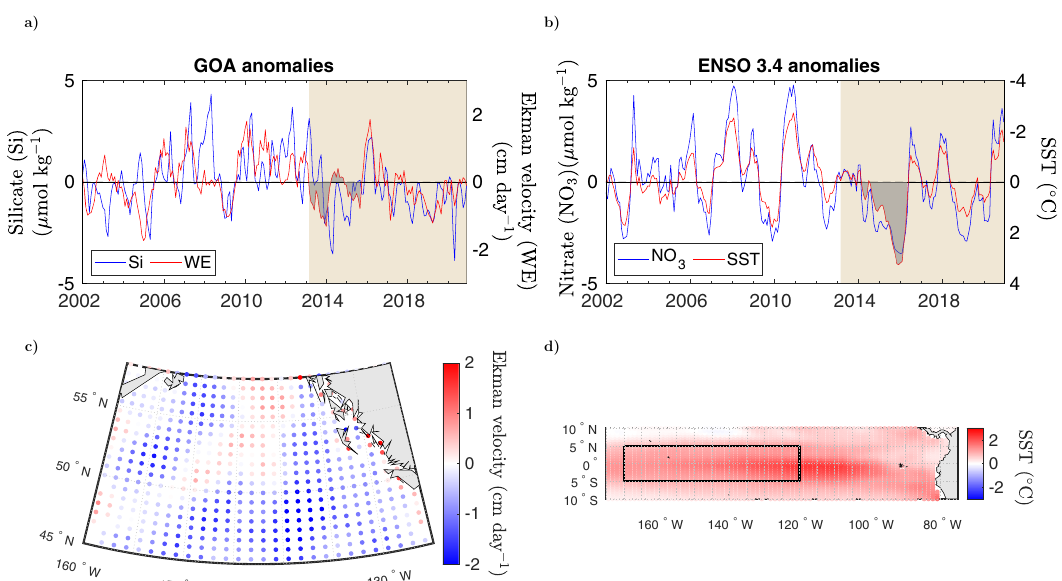
Fig. 4 Wind-driven transport and nutrient anomalies. a GOA monthly anomalies in modeled surface silicate concentration ( μ mol kg − 1 ) and Ekman vertical velocity (WE) (cm day − 1 ). Gray-shaded area in the silicate time series indicate the period of duration of the Blob between March of 2013 – October 2015. b ENSO 3.4 monthly anomalies in modeled surface nitrate concentration ( μ mol kg − 1 ) and sea surface temperature (SST) (°C). Gray-shaded area in the nitrate time series indicate the period of duration of El Niño between February of 2014 and June of 2016. c Mean anomaly in Ekman vertical velocity over GOA between March of 2013 – October 2015. d Mean anomaly in SST over ENSO 3.4 (black line rectangle area) between February of 2014 and June of